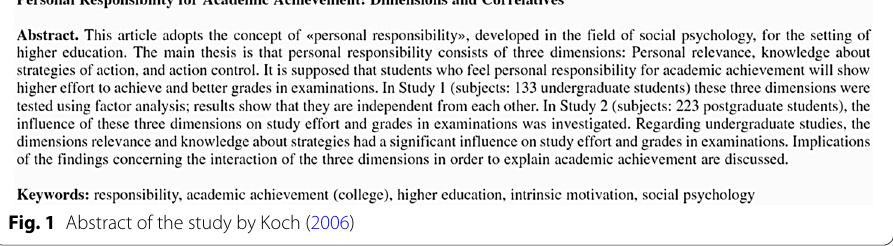
Fig. 1 Abstract of the study by Koch (2006)